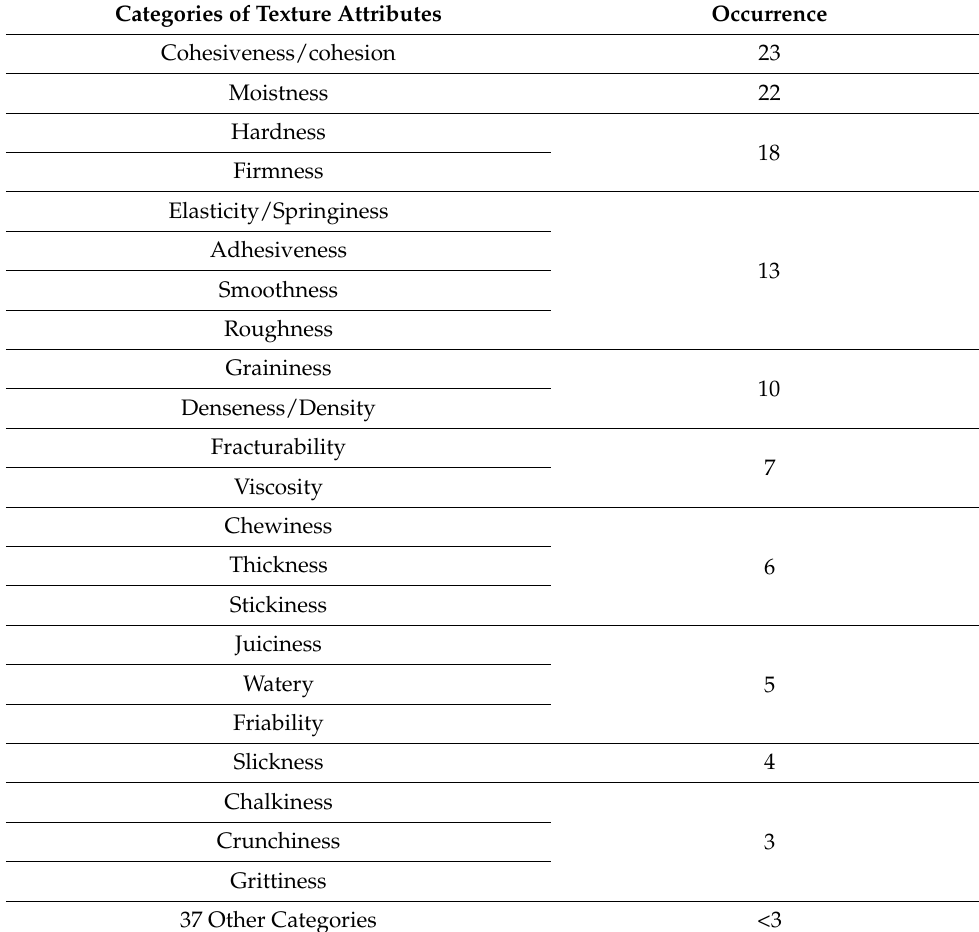
Table 2. Texture-attribute categories mentioned at least three times in articles and reviews from